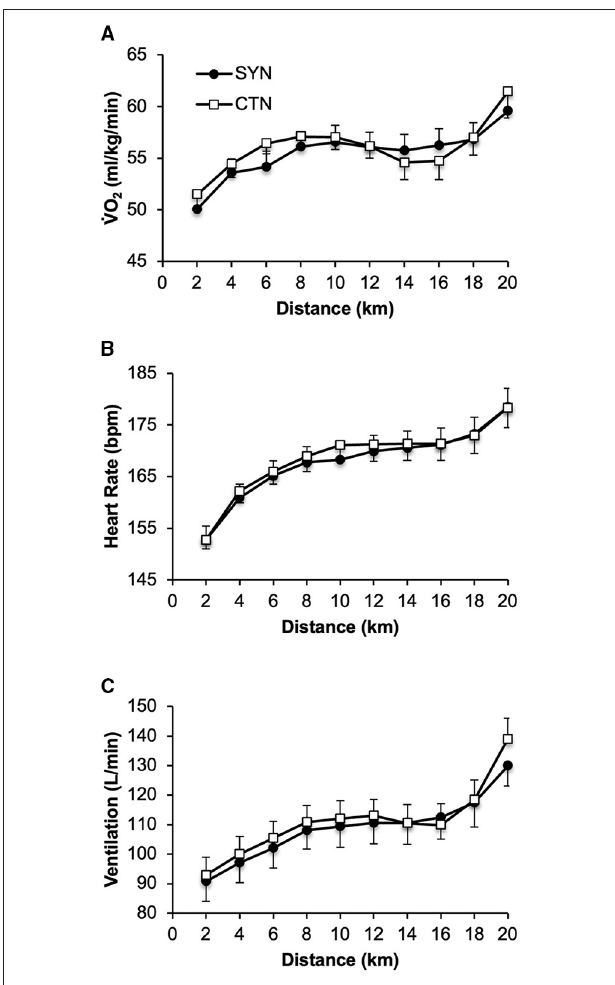
FIGURE 4 | Effect of wearing athletic clothing made of synthetic fabrics (SYN, 60% polyester: 40% nylon) and 100% cotton fabric (CTN) on (A) metabolic, (B) cardiac and (C) ventilation responses during a 20-km cycling time trial in endurance-trained adults ( n = 15). Values are means ± SE. VO 2 , rate of oxygen